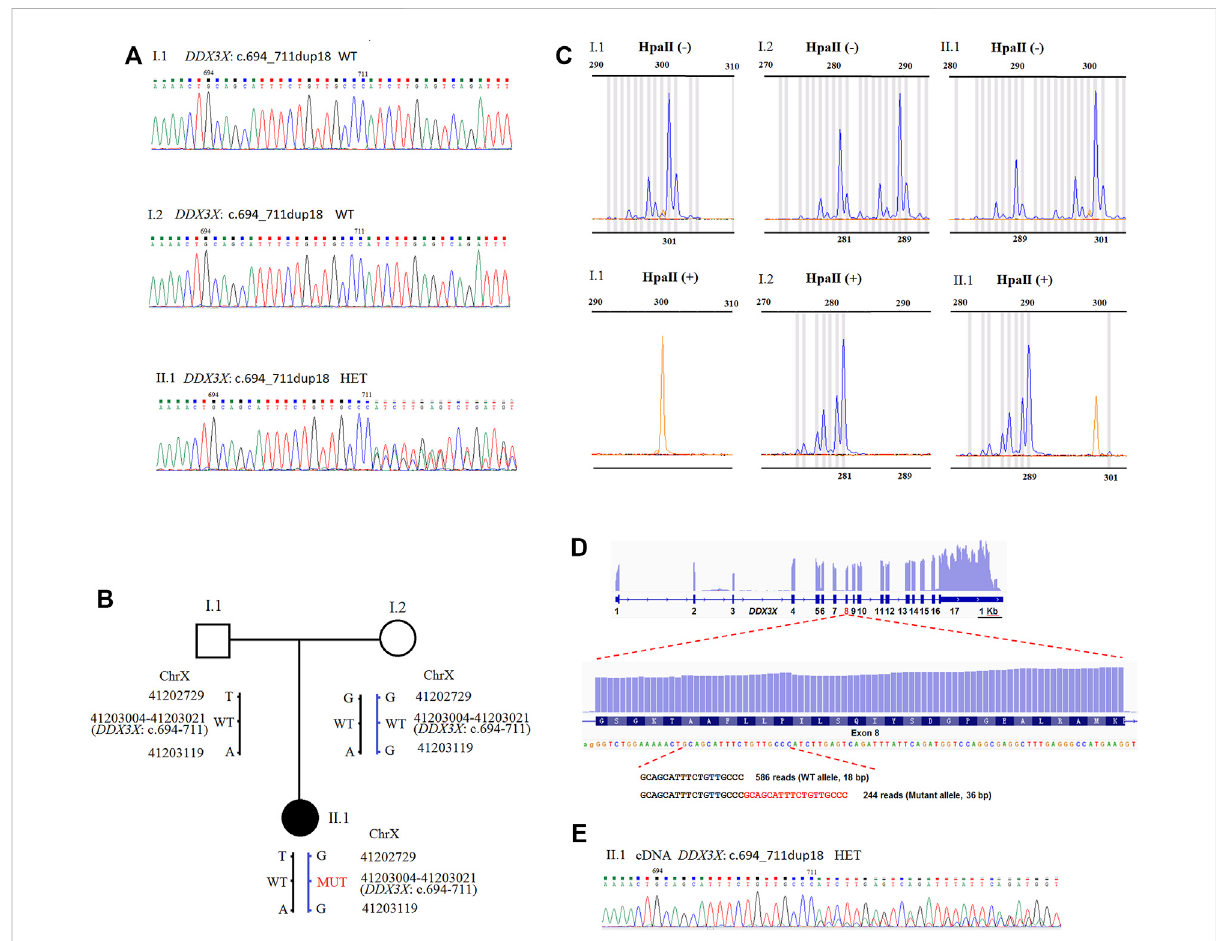
FIGURE 1 (A) Sequence analysis of genomic DNA from family members. The genotypes of DDX3X were wild type, wild type, and c.694_711dup18 HET, in I.1 (father), I.2 (mother), and II.1 (proband). (B) Schematic representation of the DDX3X mutation and two SNPs in the family. Besides the DDX3X c.694_711dup18, G > T and G > A variant were also detected at the positions NC_000023.10: g.41202729 and g.41203119 in II.1 by PCR-sanger sequencing. DDX3X c.694_711dup18 was con fi rmed to inherit from mother I.2 by the two SNPs. HET, heterozygote; WT, wild type; MUT, mutation type. (C) XCIpattern wasdetectedby AR assay.A peakof301 bp for AR wasobservedbyassayingtheundigestedPCR productofI.1and no peakswereobservedfortheHpaIIdigestedproduct.TheundigestedPCRproductofI.2gavetwopeaksof281and289 bp,andmajorpeakof281 bp was observed with the HpaII digested product. The undigested PCR product of the proband II.1 gave two peaks of 289 and 301 bp. One X-chromosomelinked with the289 bp peakof AR wasinherited fromthe mother I.2 and theother fromthe father I1. The product of HpaII digestion gave only one major peak of 289 bp. II.1 exhibited extreme skewing of XCI. The inactivated X-chromosome was linked with the 289 bp peak of AR , which inherited from the mother I.2. (D) The IGV Genome Browser view showing RNA-seq reads mapped to DDX3X locus. The numbers